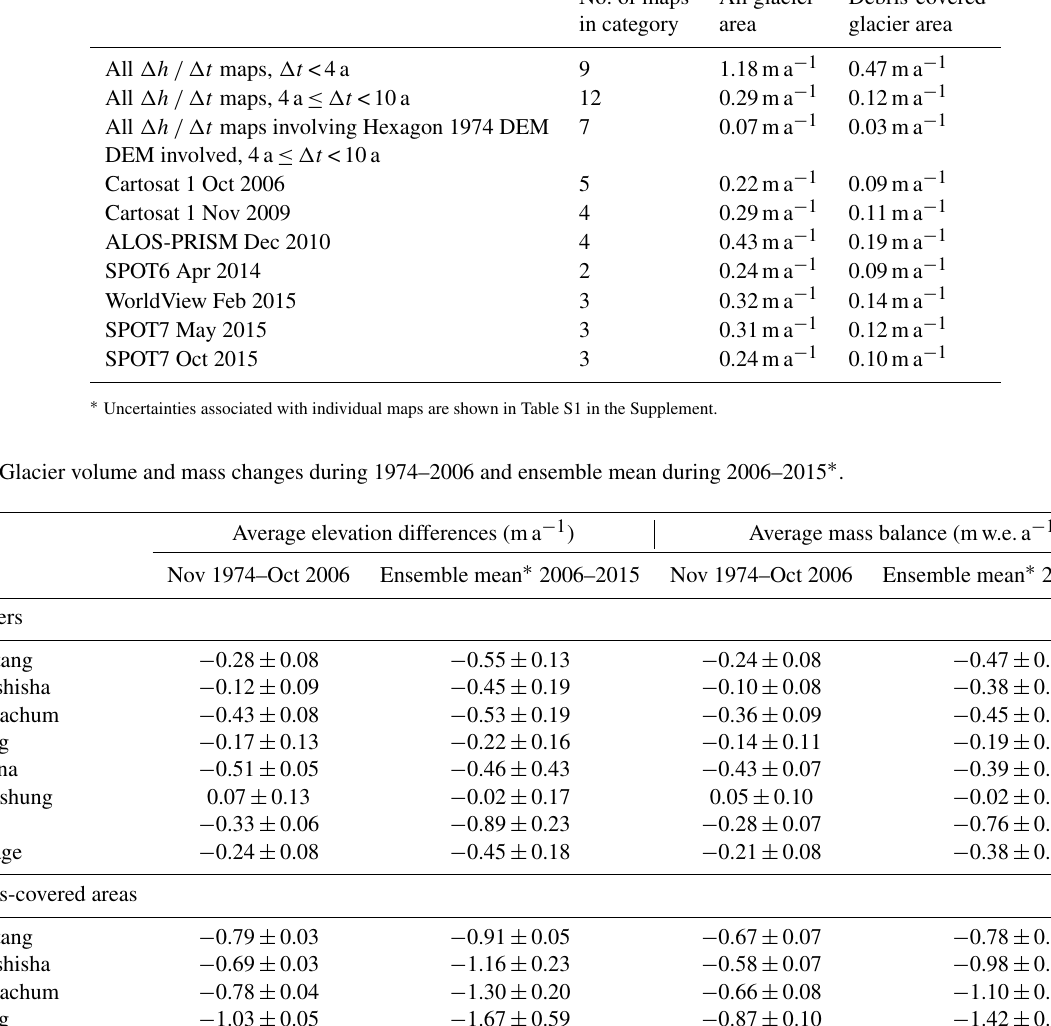
No. of maps All glacier Debris-covered in category area glacier area